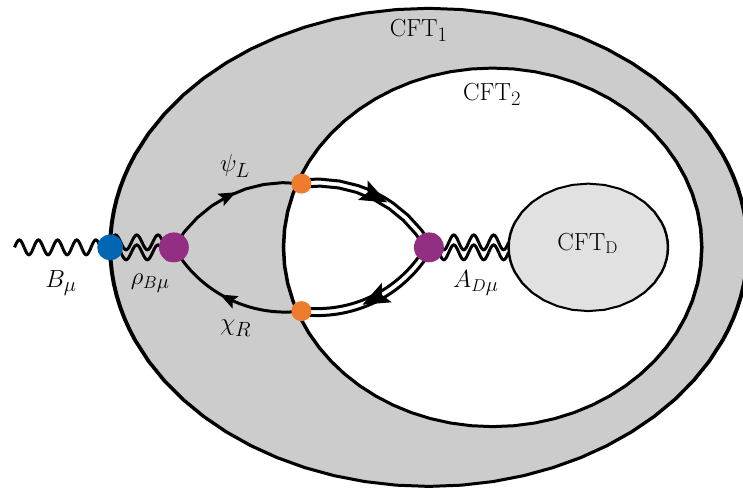
Figure 2 . A diagram responsible for the effective mixing between B µ and A gauge boson external to CFT 1 and ρ Bµ is a composite vector meson of confined phase of CFT 1 . This latter phase also includes a pair of composite fermions denoted as ψ L and χ R which couples to a composite CFT 2 as described in eq. (2.2). These couplings lead to partial-compositeness coupling once CFT 2 confines. This is shown as orange blobs. The confined CFT 2 also contains a composite vector meson A which itself is external to CFT D D µ